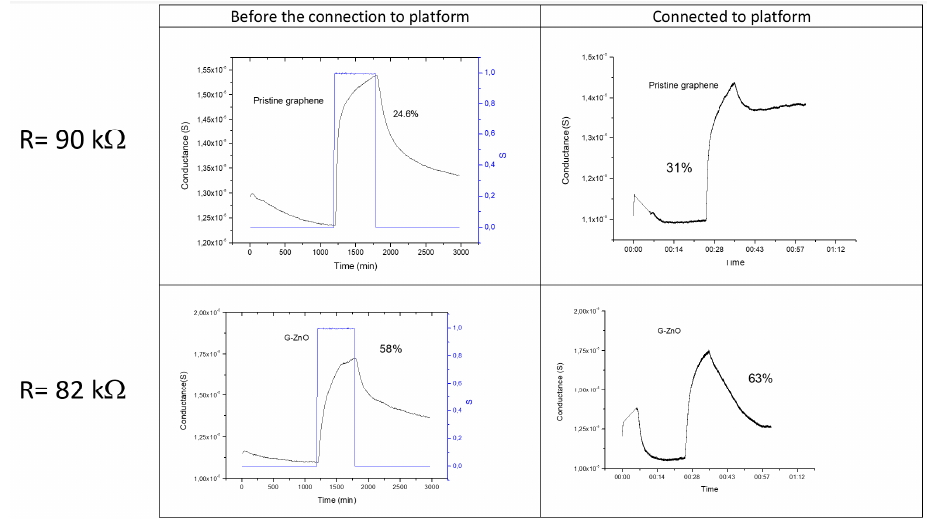
Figure 20. Sensing responses of the newly prepared devices, based on pristine and decorated graphene, exposed to 1 ppm of NO 2 for 10 min. Figure is cut off.